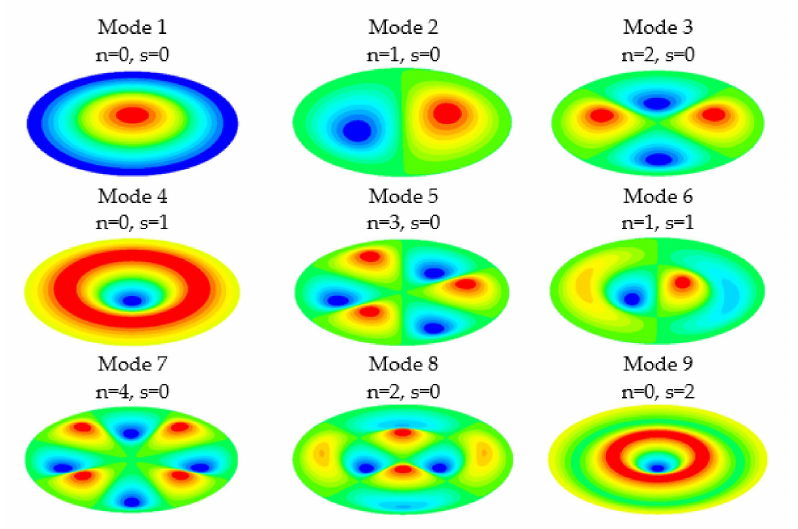
Figure 2. Modal shapes of the first 9 vibration